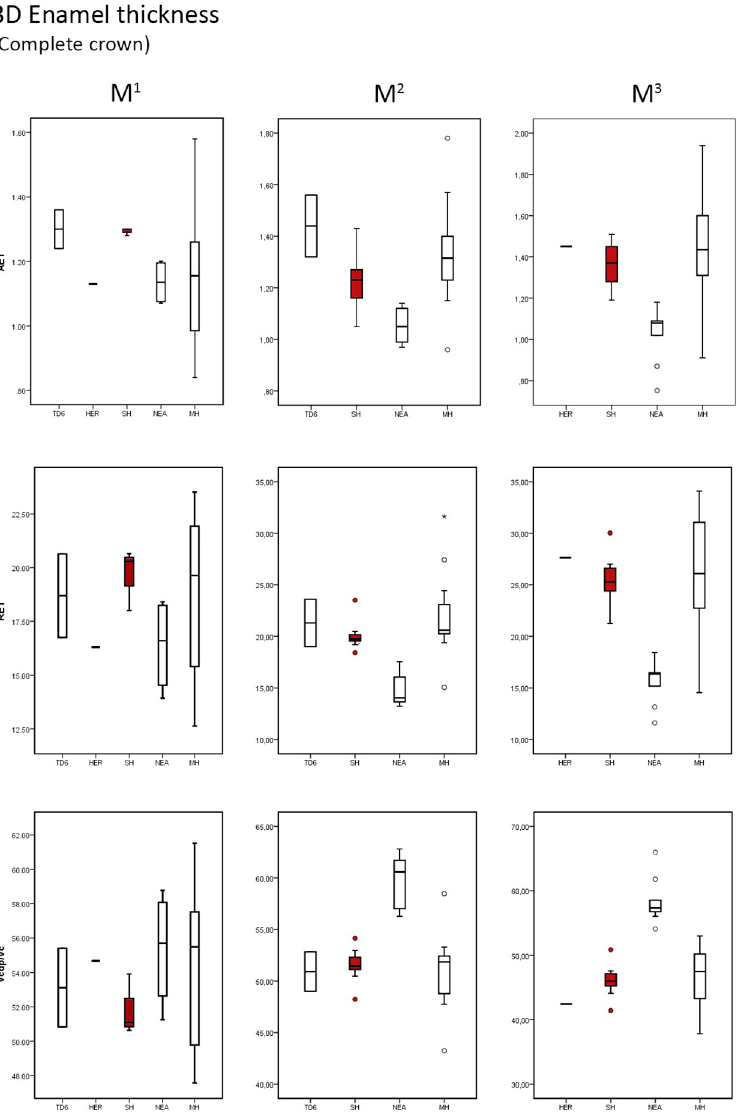
Fig 4. Box plots of the 3D, complete crown, values. 3D values depicting the average enamel thickness (3D AET), relative enamel thickness (3D RET) and the percentage of dentine and pulp in the total crown volume (Vcdp/Vc), in the maxillary molars of the SH and the comparative